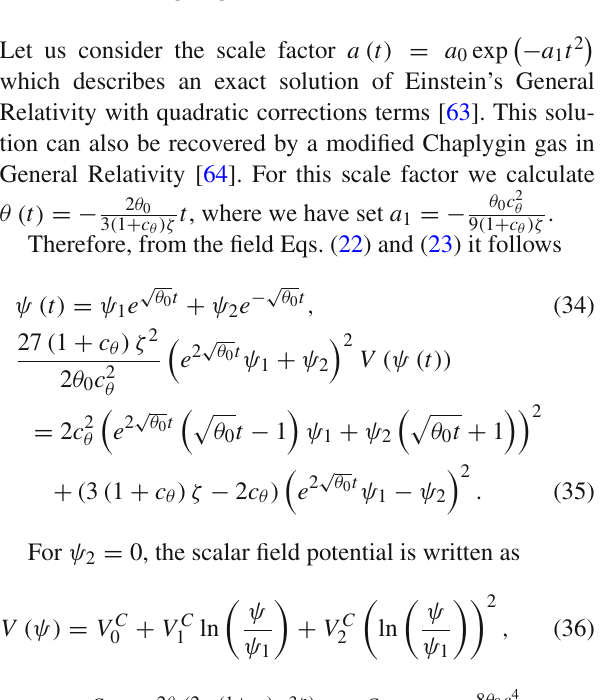
= 2 a 2 c 2 θ ( 2 q + + θ 0 ) 1 3 ζ . The parametric plot of the